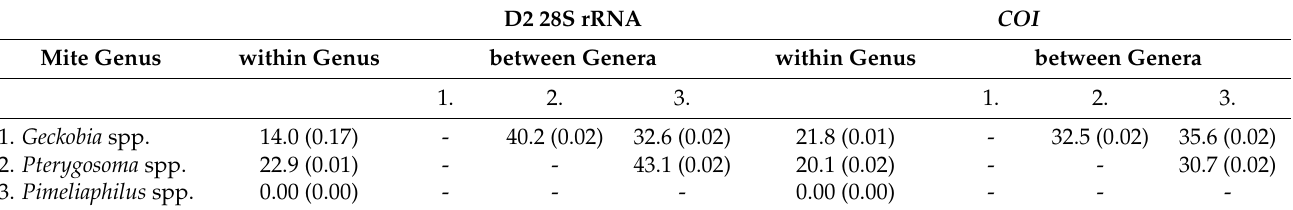
Table 5. Kimura two-parameter distances (presented as percentages with standard error estimates in parentheses) between D2 sequences and COI among genera and between genera.